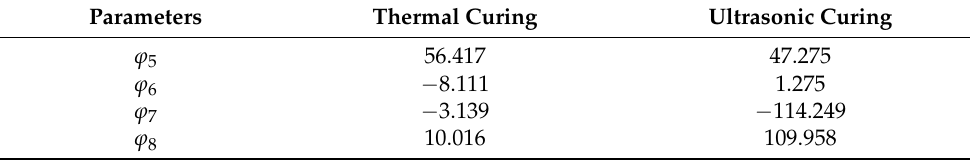
Table 3. Parameters for ln A and E ( α ).